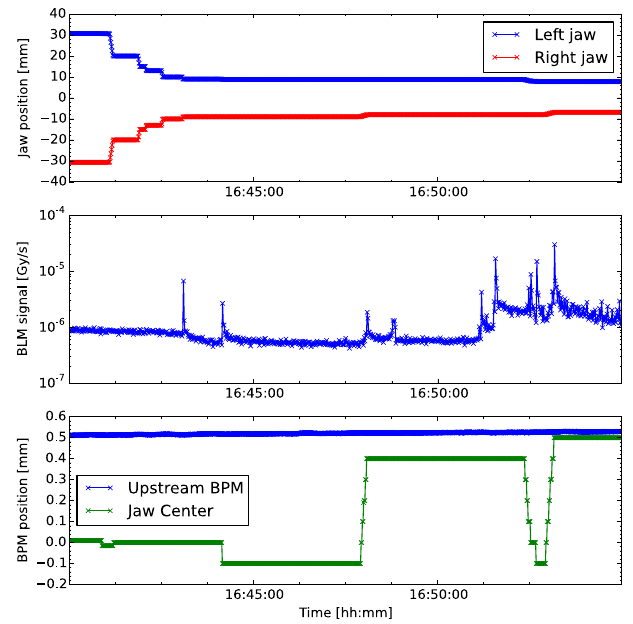
FIG. 9. Beam-based alignment of the rotatable collimator prototype, showing the left and right jaw positions (top), the recorded BLM signal (middle), and a comparison of the colli- mator center to the beam position measured by the upstream BPM (bottom) as a function of time.